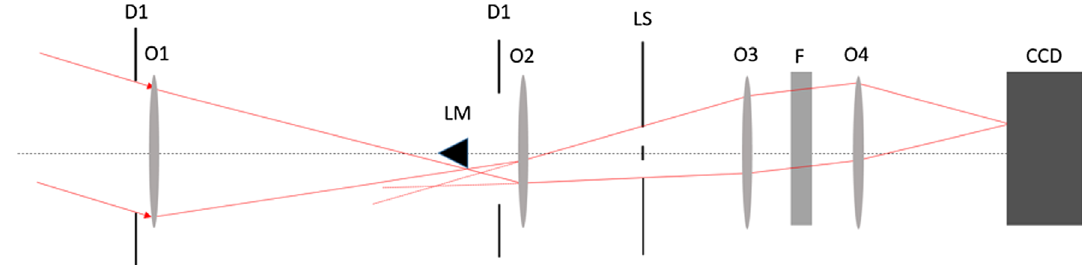
Fig. 4. Schematic of the coronagraphs ’ optics with the paths of two rays of sunlight. (Adapted from Dettwiller & Noëns, 2008).